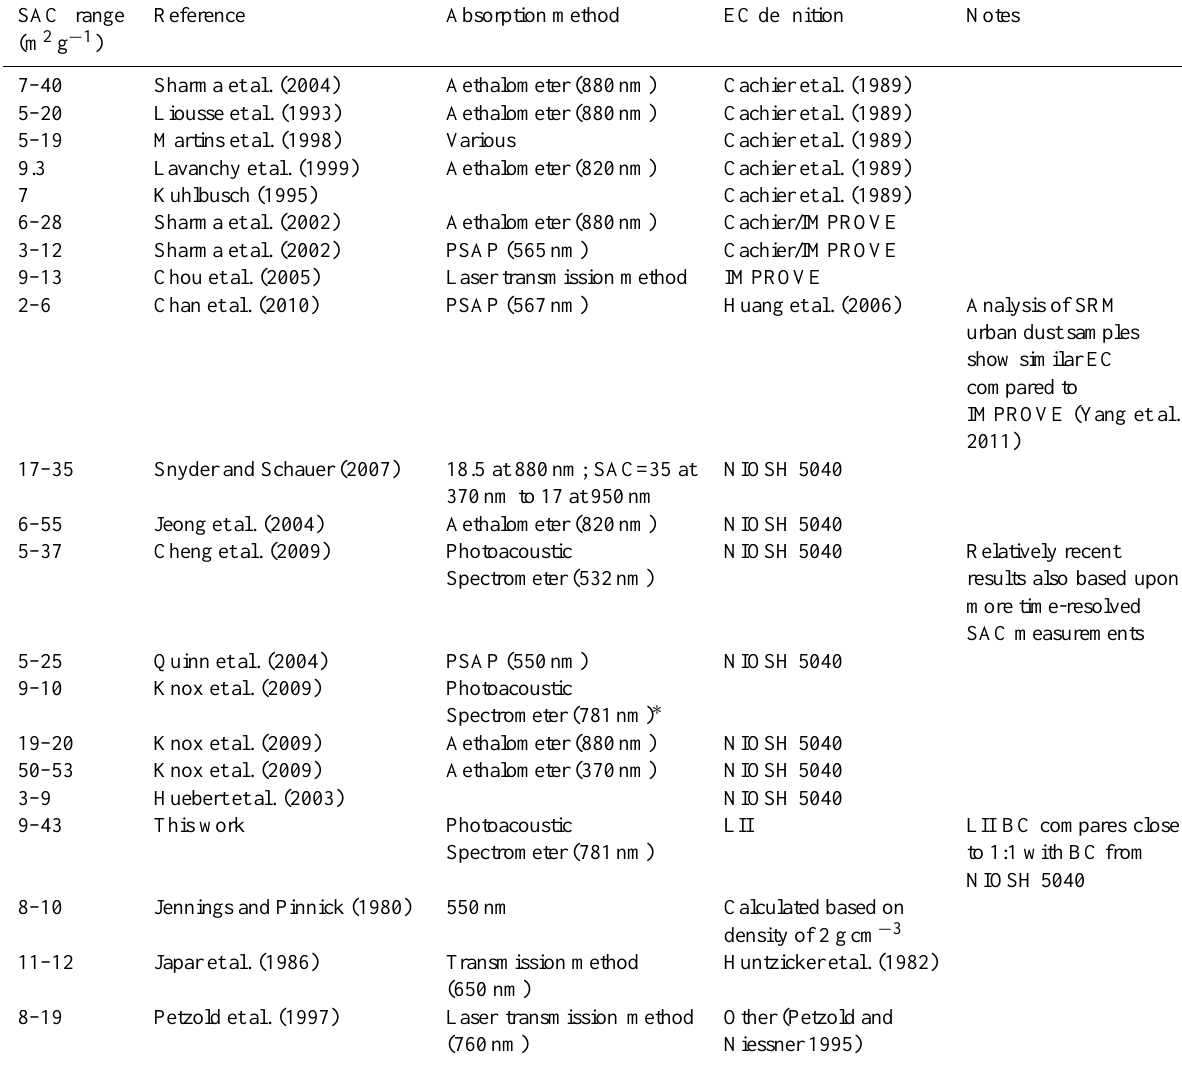
Table 2. Previous reported ranges of SAC values measured for atmospheric